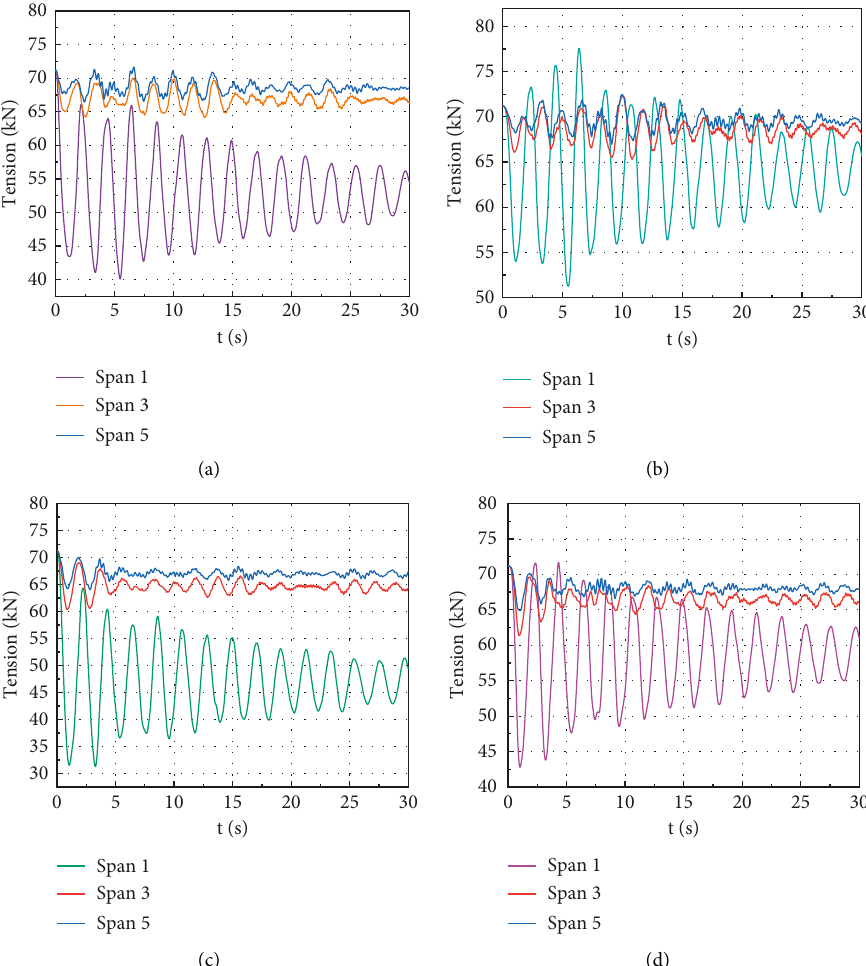
Figure 15: Tension-time curves of subconductors with span number: (a) A1 conductor, (b) A2 conductor, (c). A3 conductor, (d) A4 conductor.